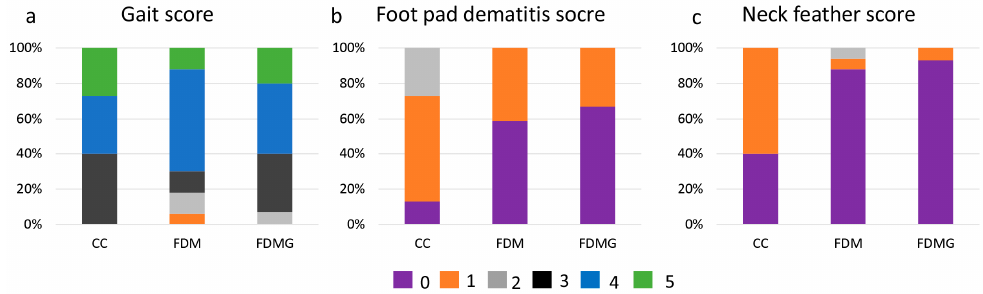
Figure 1. Gait score, foot pad dermatitis score, and feather condition score of chickens ( n = 45). CC = conventional cage feeding, FDM = free dietary choice of mealworms feeding, FDMG = free dietary choice of mealworms and grass feeding and FRMG = free-range rearing system. Gait scores of 0, 1, 2, 3, 4, and 5 represent normal walking, abnormal walking, obviously lame, able to walk under strong stimulation, unable to walk, and unable to stand. Foot pad dermatitis scores of 0, 1, 2, 3, and 4 represent no injury, slight injury on <5% of the pads, a few injuries on 5–25% of the pads, moderate injuries on 25–50% of the pads, and severe injury on >50% of the pads. Feather scores of 0, 1, 2, 3, and 4 represent no feather loss, slight feather loss but not bare, size of bare patch < 3 × 3 cm, and size of bare patch > 3 × 3 cm.